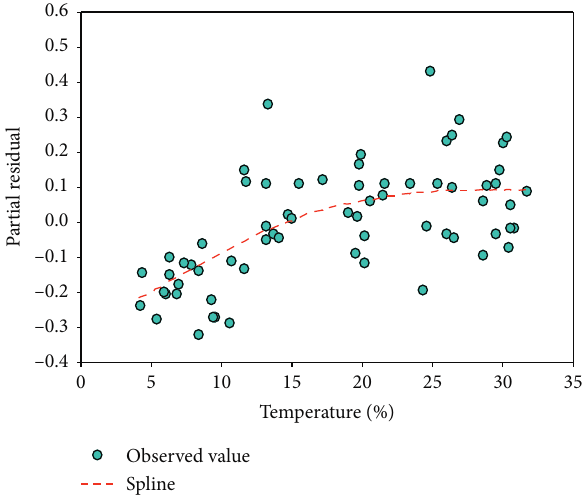
Figure 7: The individual response of the water consumption to temperature.